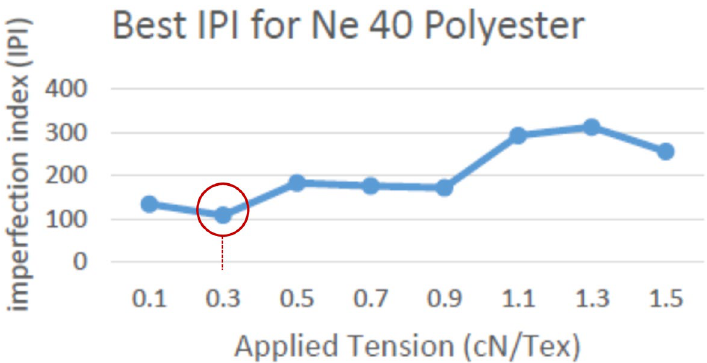
Figure 16. Best IPI for yarn count Ne 40 polyester yarn.